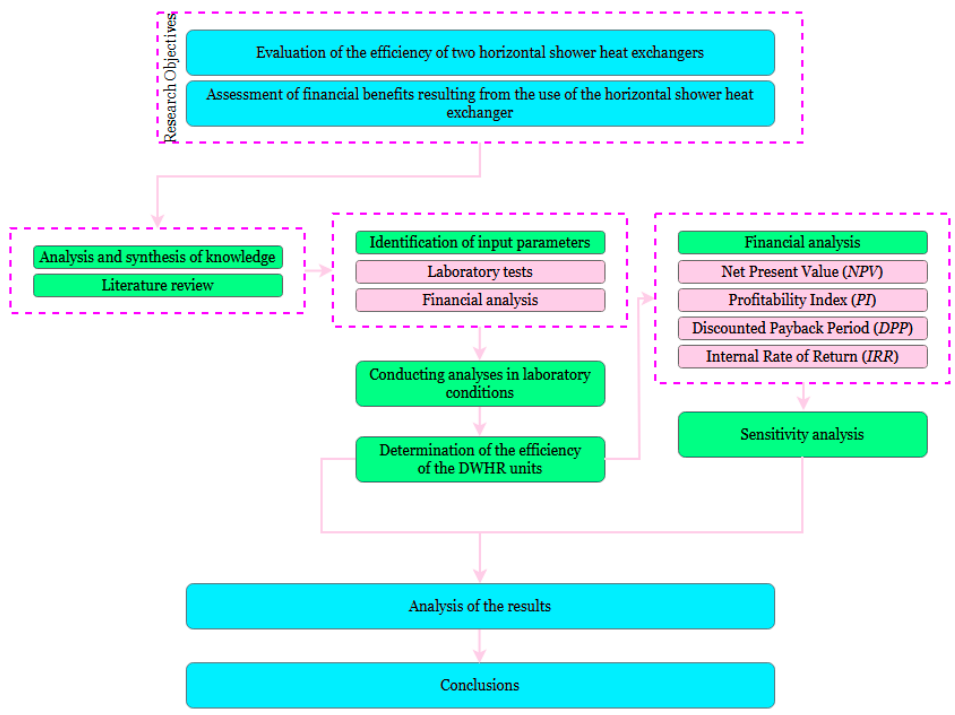
Figure 3. Research plan.